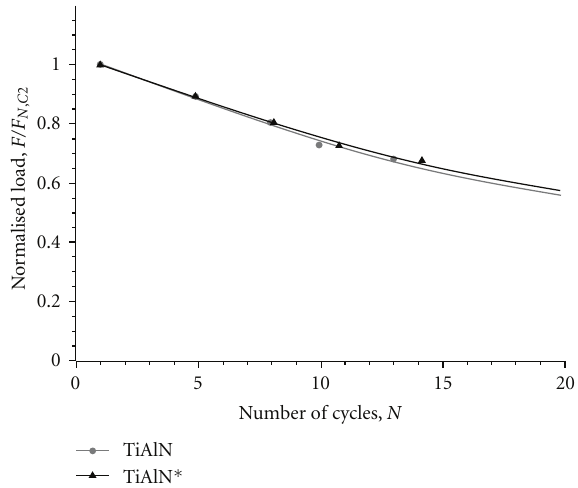
Figure 12: Normalised load-number of cycles curves for the Ti 0 . 34 Al 0 . 66 N coating showing the normalised normal load for continuous interfacial spalling. The ∗ indicates retesting after long term testing of the other coatings investigated.